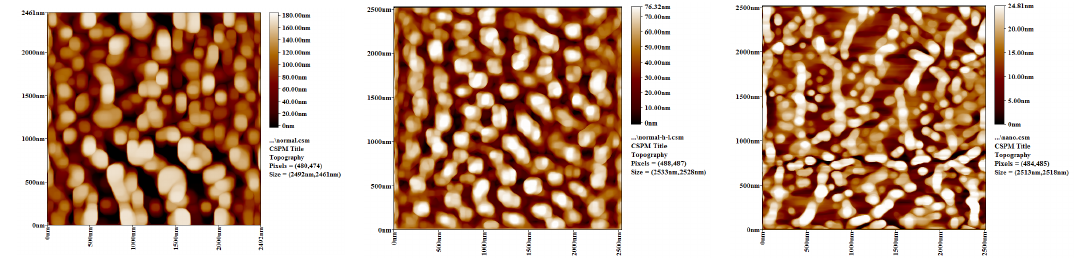
Figure 2. The HL particle size distribution measured by DSL.